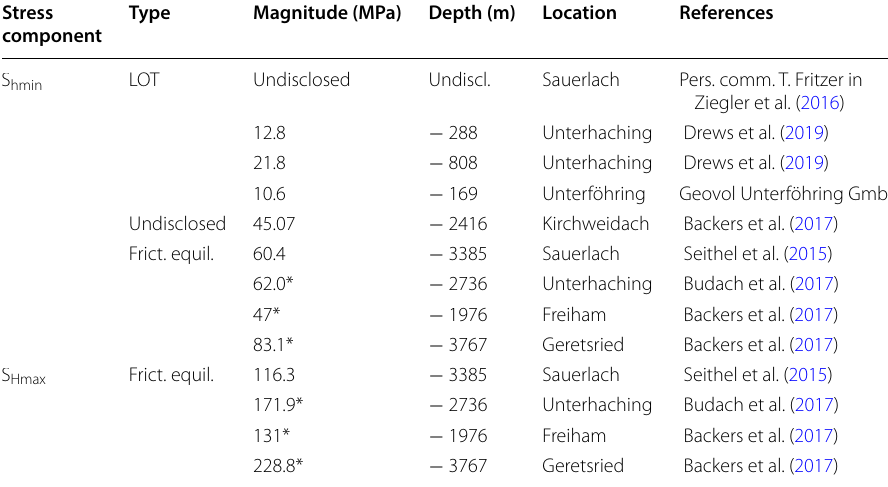
The asterisk signifies that the magnitudes are assumed for a strike-slip regime. For the corresponding magnitudes for a transtensional stress regime, see Table 3